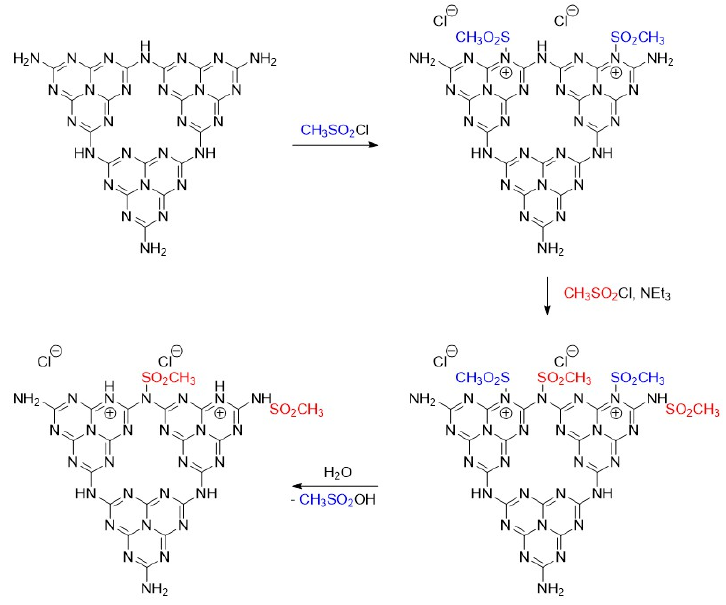
Figure 7. Proposed structure of CN after derivatization with mesyl chloride and its formation (only two melem units are depicted for simplicity of the scheme).